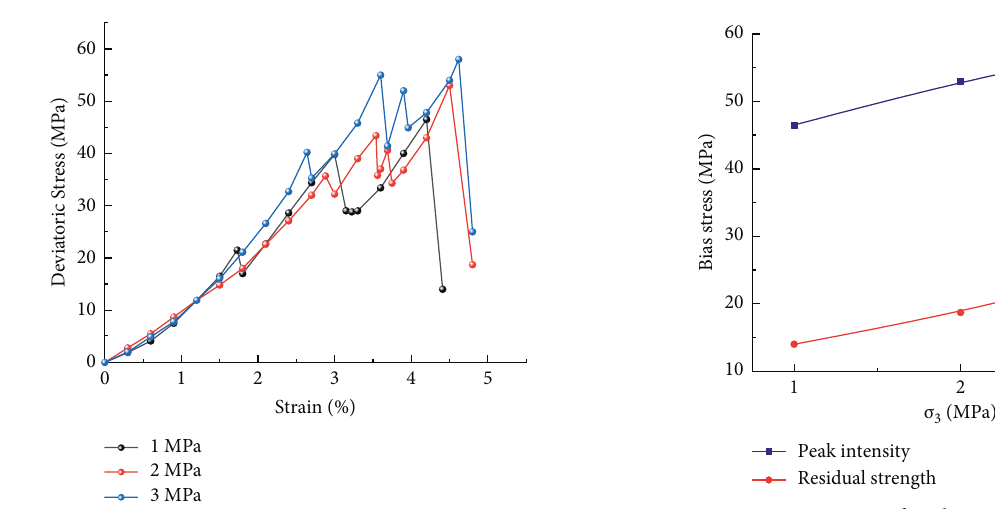
Figure 13: Stress-strain curves of fine sandstone specimens with different confining